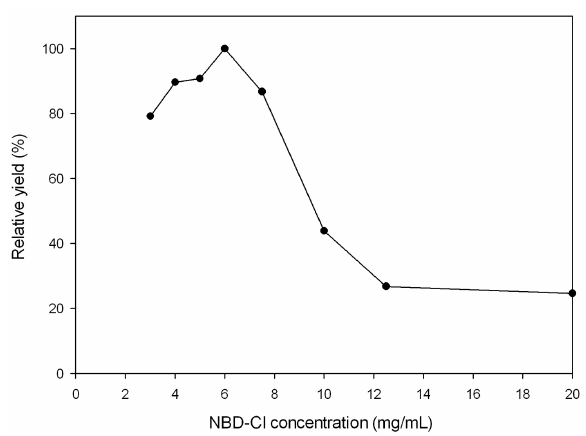
Figure 2. The effect of NBD-Cl concentration on the relative yield of derivatization reaction with